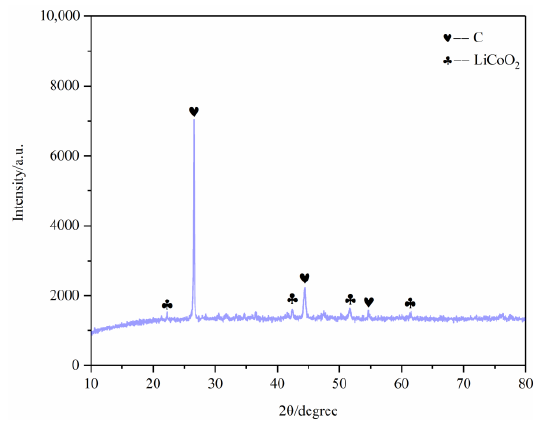
Figure 16. SEM of battery materials after pyrolysis at 600 °C.